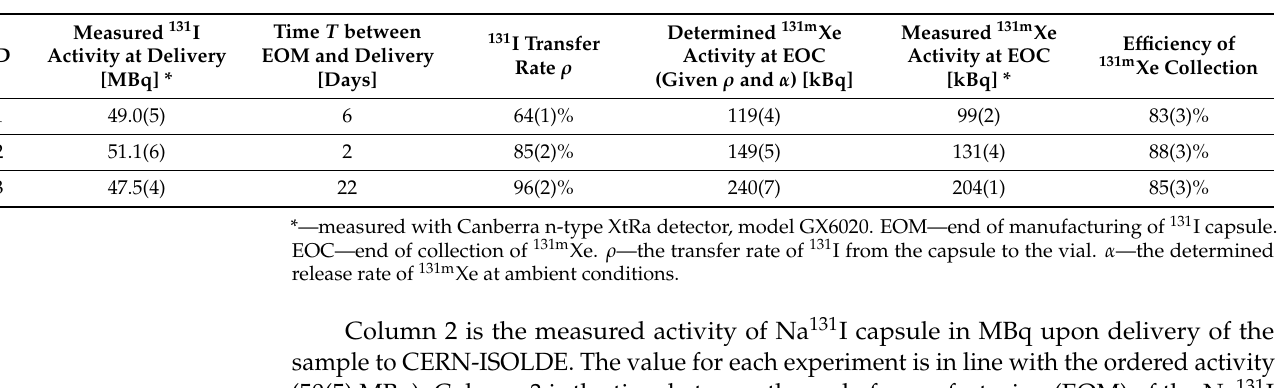
Table 2. Efficiency of 131m Xe production and collection from decay of 131